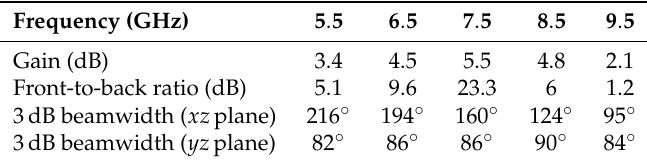
Figure 4. Reference antenna: ( a ) Realized gain in the xz plane ( φ = 0). ( b ) Realized gain in the yz plane ( φ = 90). The maximum cross-polarization level, not plotted here for brevity, is less than 57dB and 45dB for φ = 0 and φ = 90, respectively. Table 1. Gain and beamwidth of the reference antenna (Figure3).